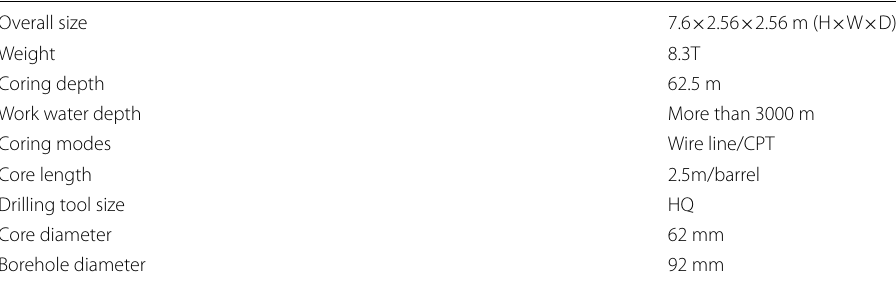
Table 2 Parameters of the seafloor drill Overall